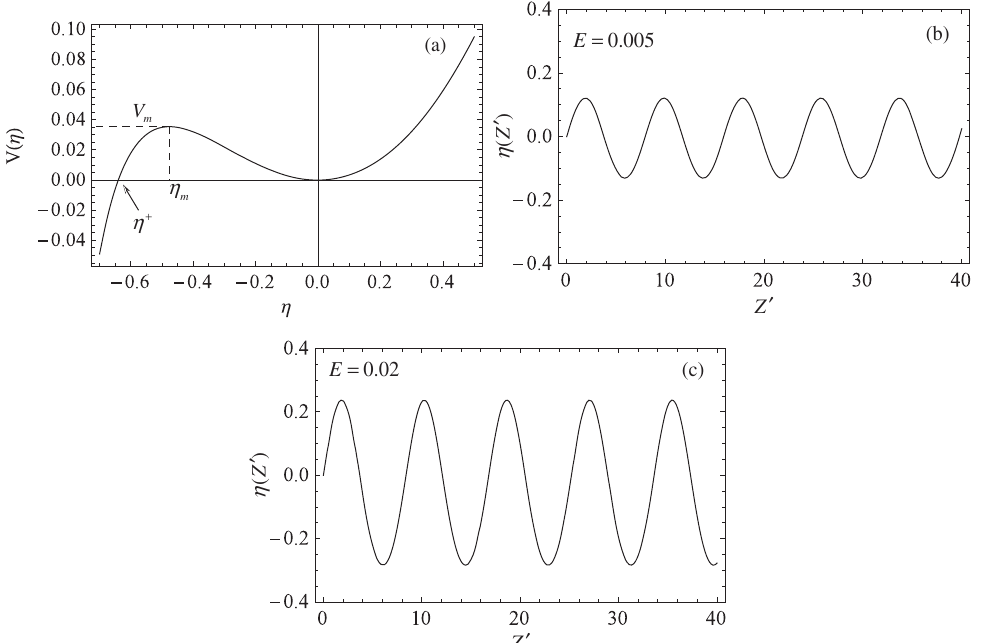
0 , η þ ¼ − 0 . 64 , η − 0 . 476 and V ð η 0 . 0355 , plots are shown for (a) V ð η Þ versus η ; (b) η ð Z 0 Þ FIG. 2. For M 2 ¼ 0 . 36 , ϵ T ¼ m ¼ m Þ ¼ versus Z 0 for η 0 ð 0 Þ ¼ 0 . 1 and E ¼ ð 1 = 2 Þ½ η 0 ð 0 Þ(cid:4) 2 ¼ 0 . 005 ; and (c) η ð Z 0 Þ versus Z 0 for η 0 ð 0 Þ ¼ 0 . 2 and E ¼ ð 1 = 2 Þ½ η 0 ð 0 Þ(cid:4) 2 ¼ 0 . 02 .